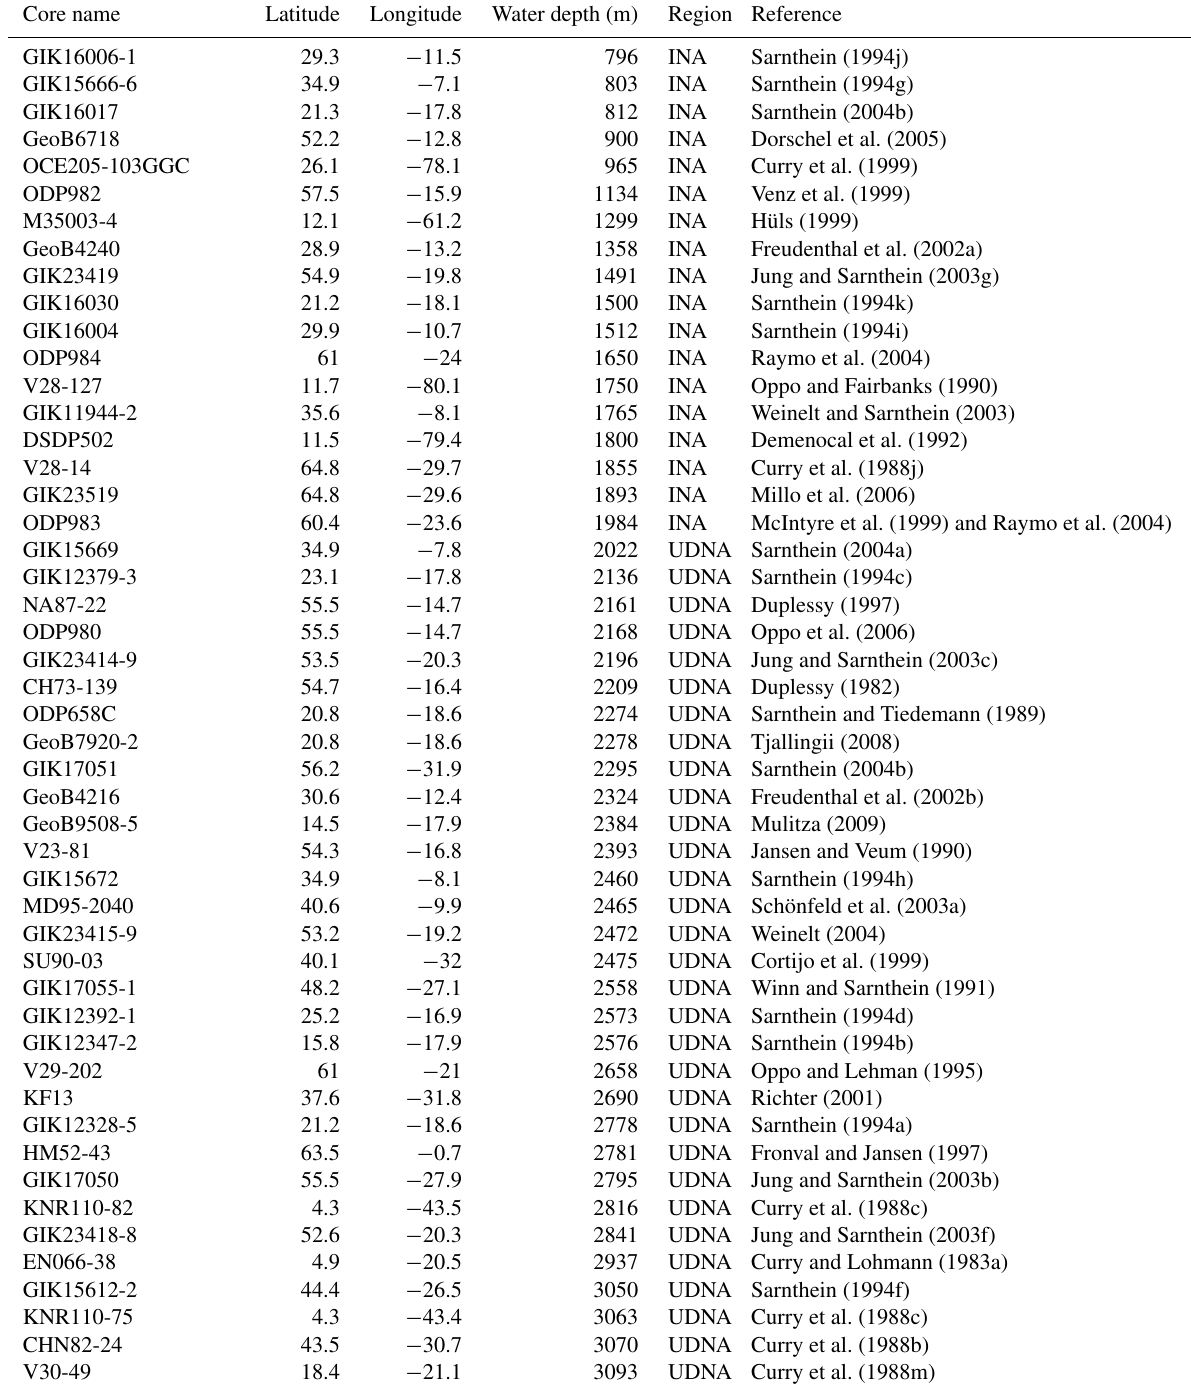
Table A1. Supplemental table of the name, location, region, and reference for each record in this δ 13 C synthesis. Asterisks mark cores for which we use the cited authors’ radiocarbon age model instead of using the regional age model from Stern and Lisiecki (2014). Data repository links for each δ 13 C record are provided in Table S1 in the